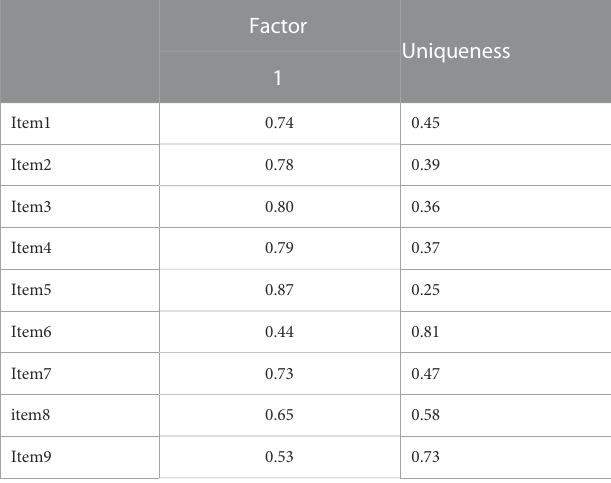
TABLE 5 Exploratory factor analysis (N = 143).